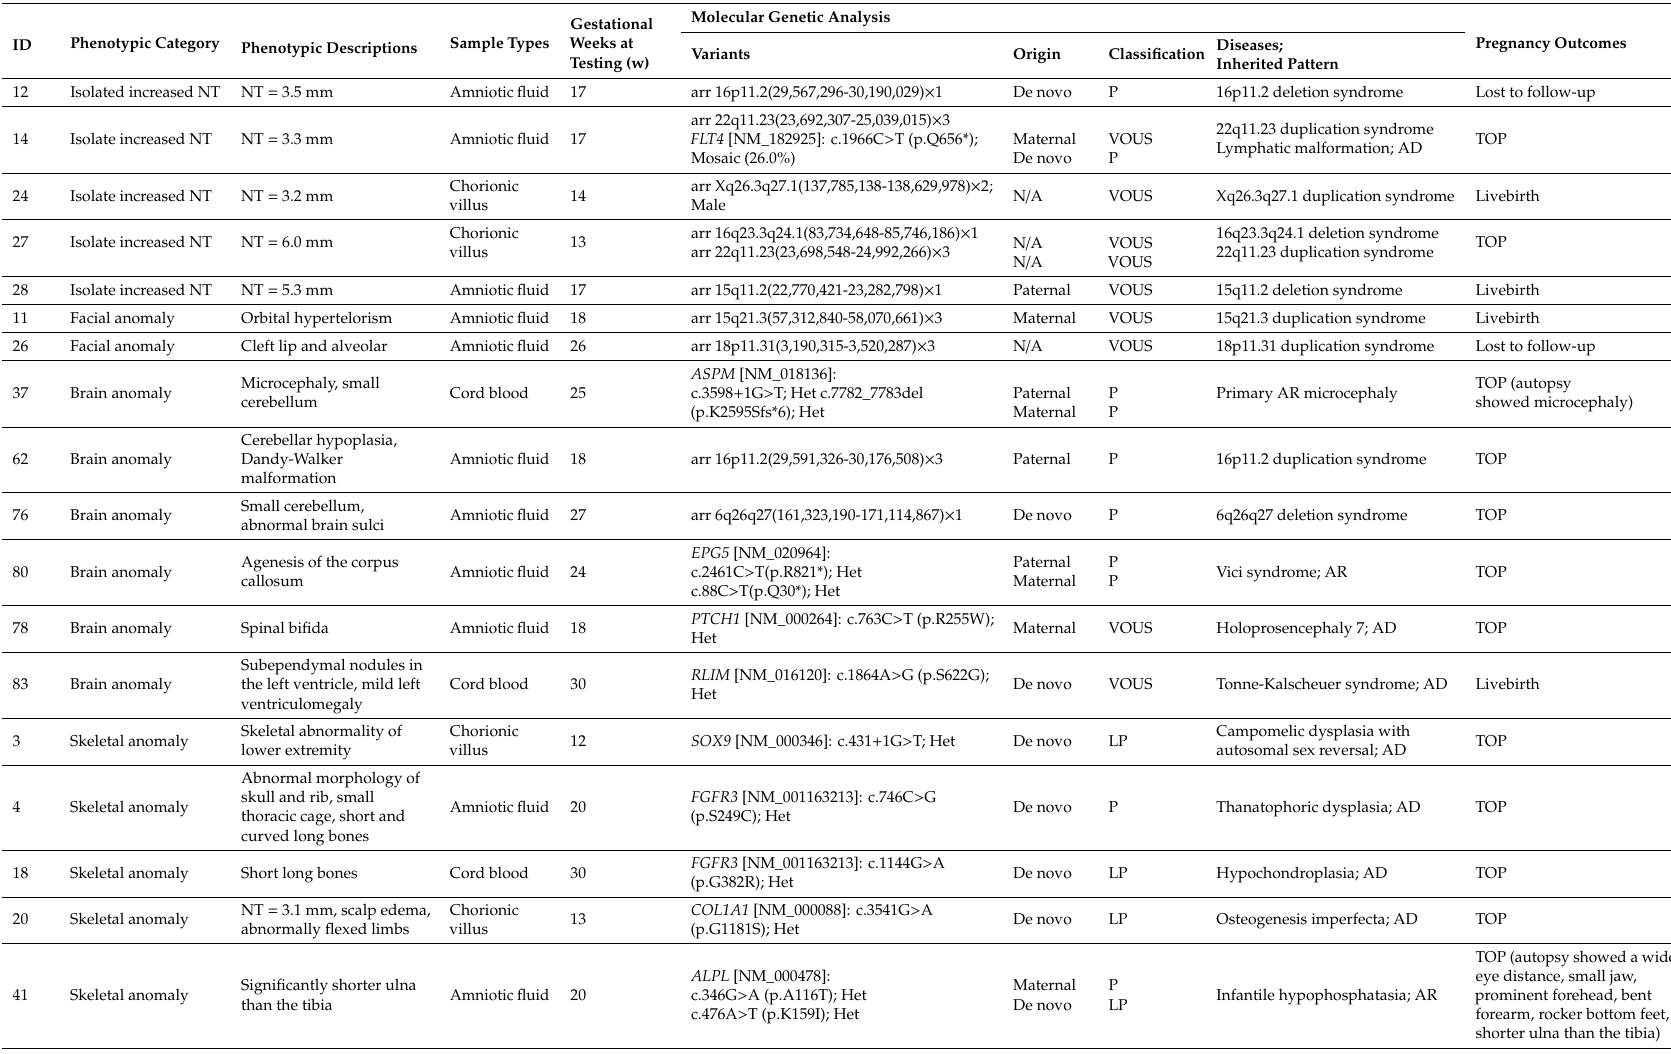
Table 2. Fetal phenotypes and pregnancy outcomes in 30 cases with P / LP variants and 15 cases with VOUS detected by CMA and